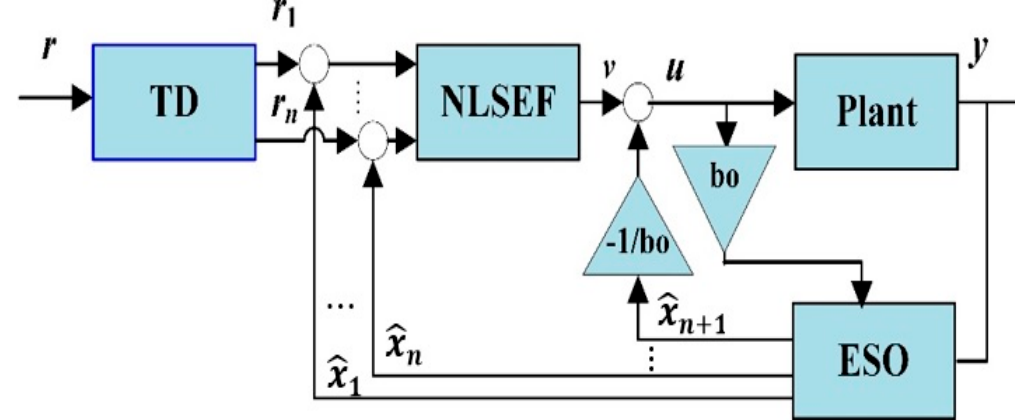
Figure 1. Structure of conventional Active Disturbance Rejection Control (ADRC).